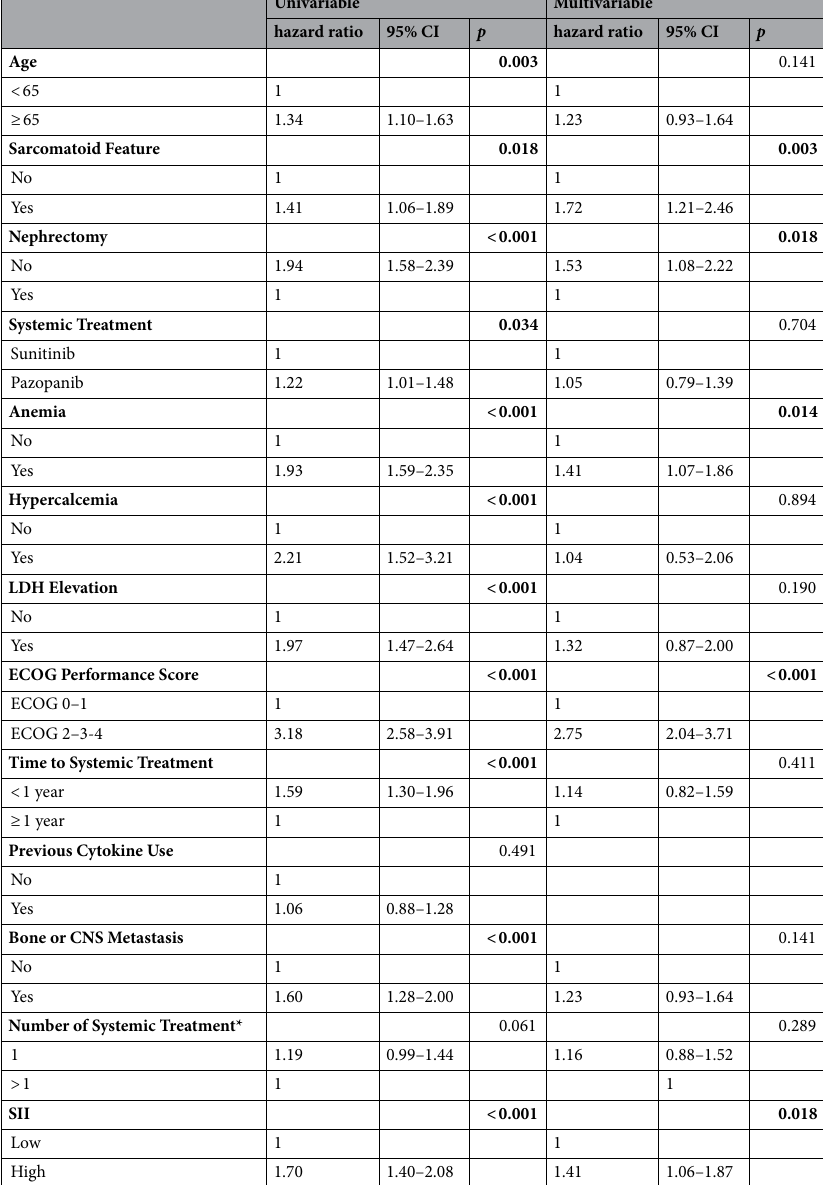
Table 2. Univariable and multivariable analysis of overall survival. CI confidence interval , CNS central nervous system , ECOG eastern cooperative oncology group , LDH lactate dehydrogenase , SII systemic immune-inflammation index. Significant values are in bold. * Except for